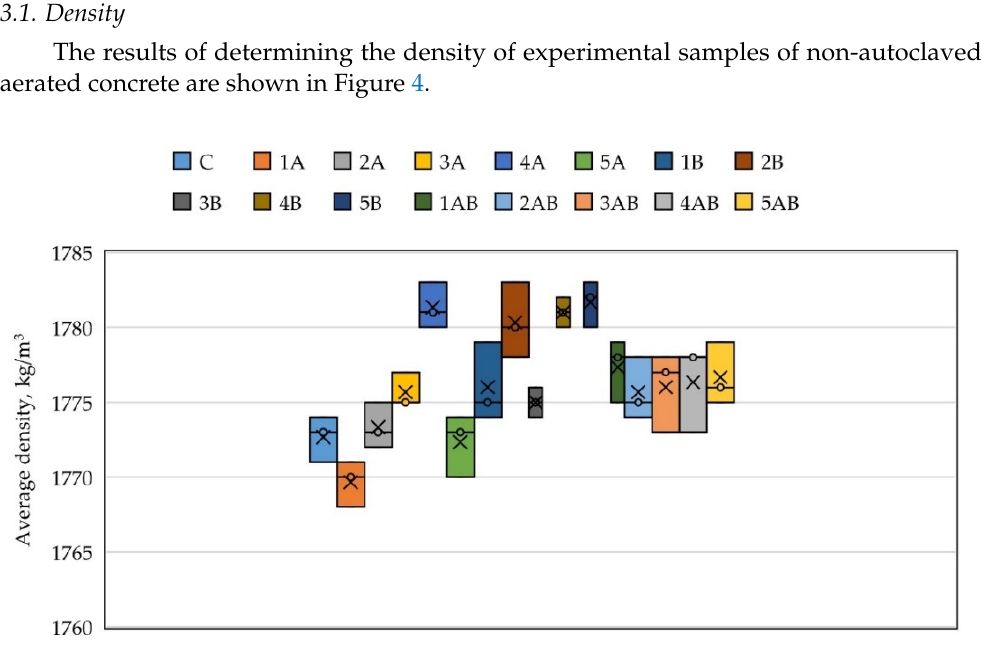
Figure 4. Statistical density values of non-autoclaved aerated concrete.